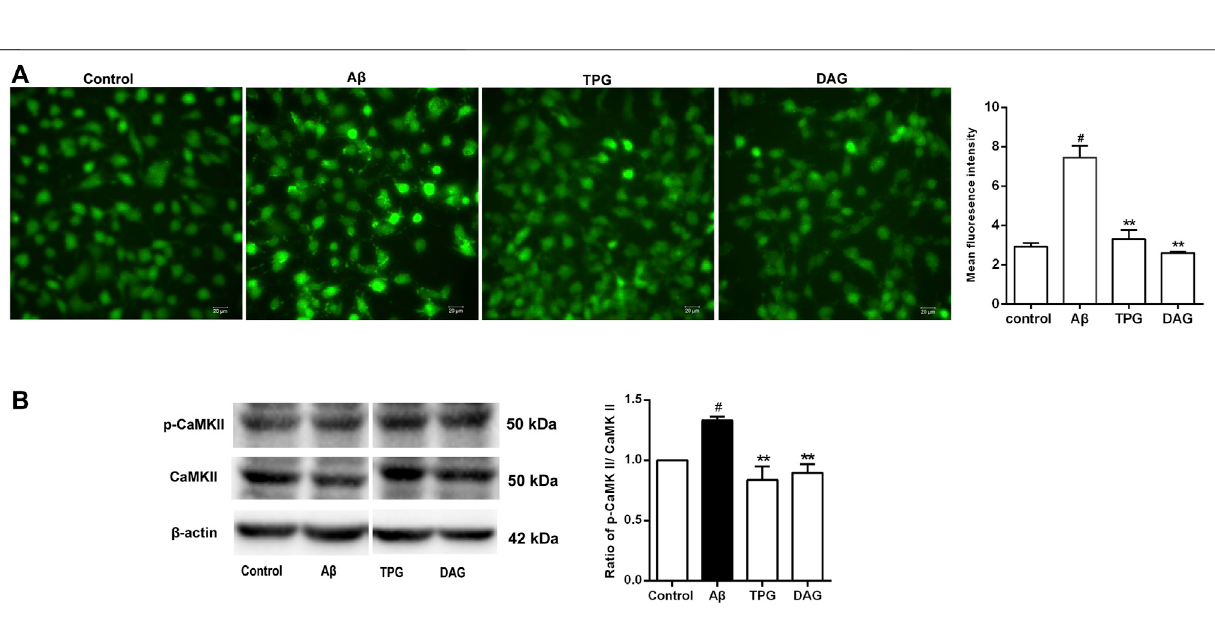
Frontiers in Pharmacology |